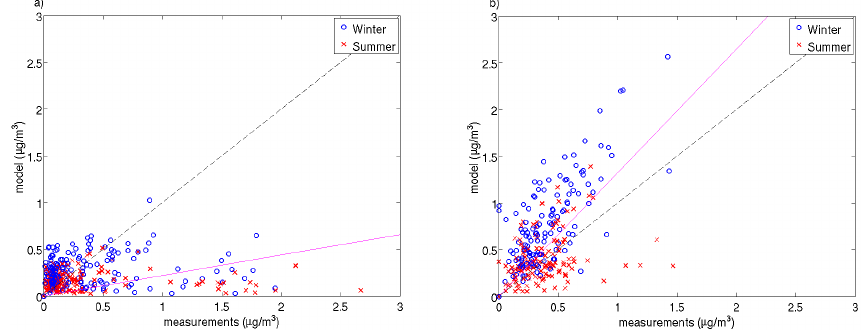
Figure 9. Comparison of measured (EMEP stations) and modelled (simulation ossa-ref ) monthly mean sodium ion concentration in (a) PM 2 . 5 and (b) PM 10 at various sites for the years 2006–2011. Blue circles indicate boreal winter months (October–March) and red crosses indicate boreal summer months (April–September). The violet line is the linear regression line for all